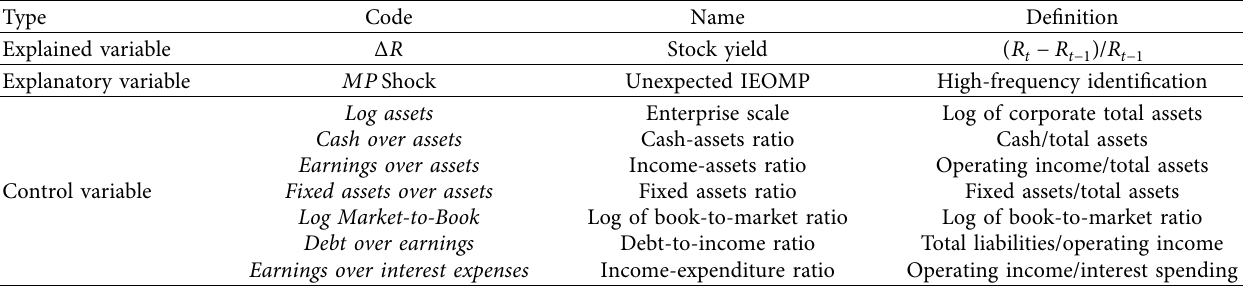
Table 1: Variables for empirical analysis.